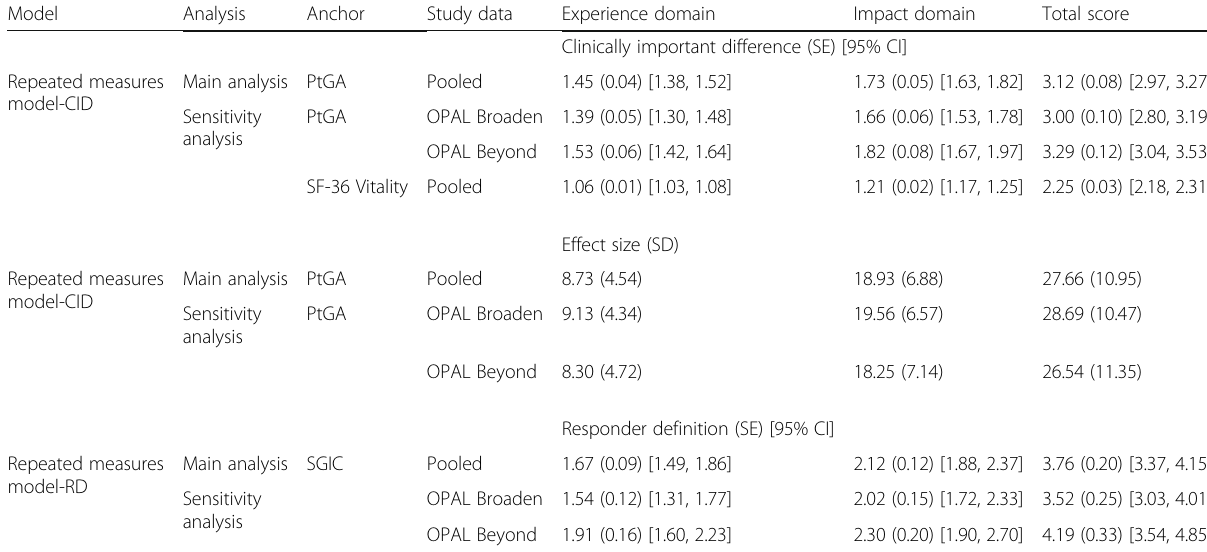
Table 4 Clinically important difference (CID) and responder definition (RD) estimations for FACIT-Fatigue in patients with PsA